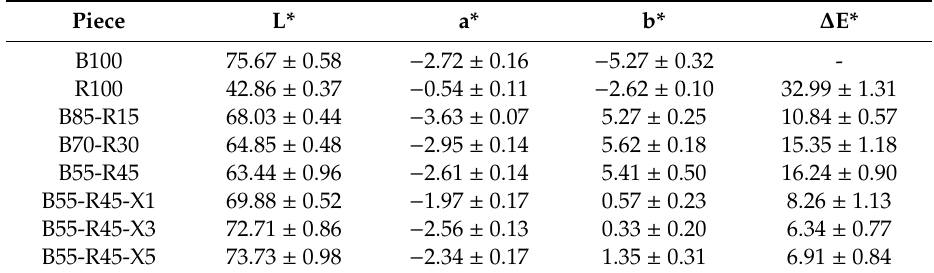
polyethylene terephthalate (bio-PET / r-PET) blend pieces.